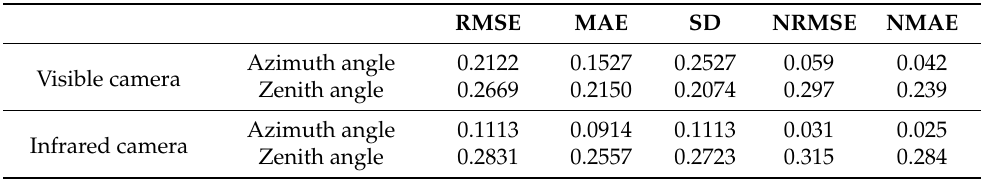
Table 2. Quantitative comparison of the back projection errors of the visible and infrared all-sky-view cameras by using the RMSE, NRMSE, MAE, NMAE, and SD. The units of RMSE, MAE, and SD are in degree ( ◦ ), and those of NRMSE and NRMSE are in percent (%). RMSE MAE SD NRMSE NMAE Azimuth angle 0.2122 0.1527 0.2527 0.059 0.042 Visible camera Zenith angle 0.2669 0.2150 0.2074 0.297 0.239 Azimuth angle 0.1113 0.0914 0.1113 0.031 0.025 Infrared camera Zenith angle 0.2831 0.2557 0.2723 0.315